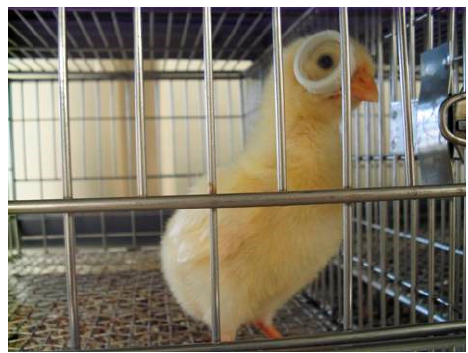
Figure 8. Photograph of a chick wearing a negative lens (–8D).